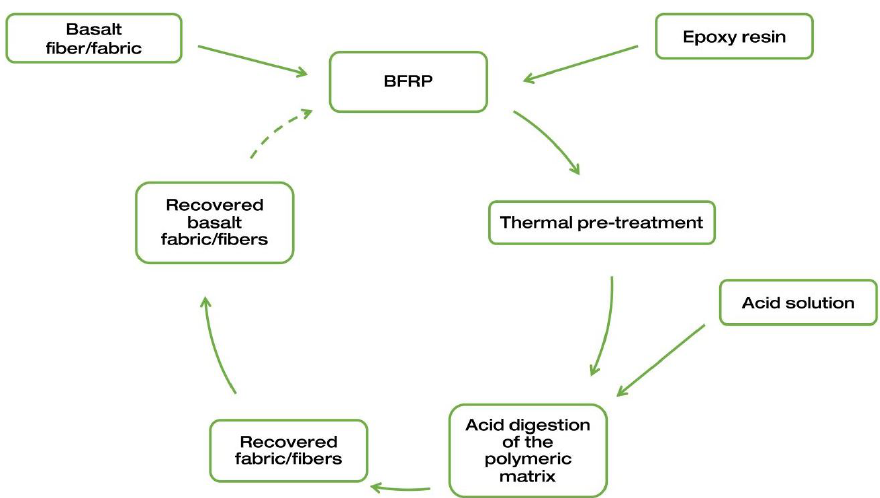
Figure 2. Recycling process of basalt fibers by